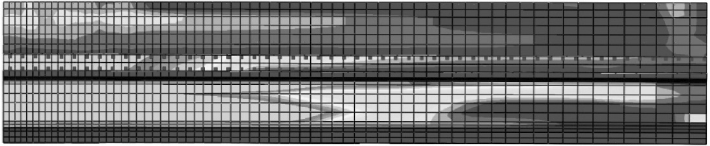
Fig. 29. Maximum principal plastic strain, blast below. Side view of interior